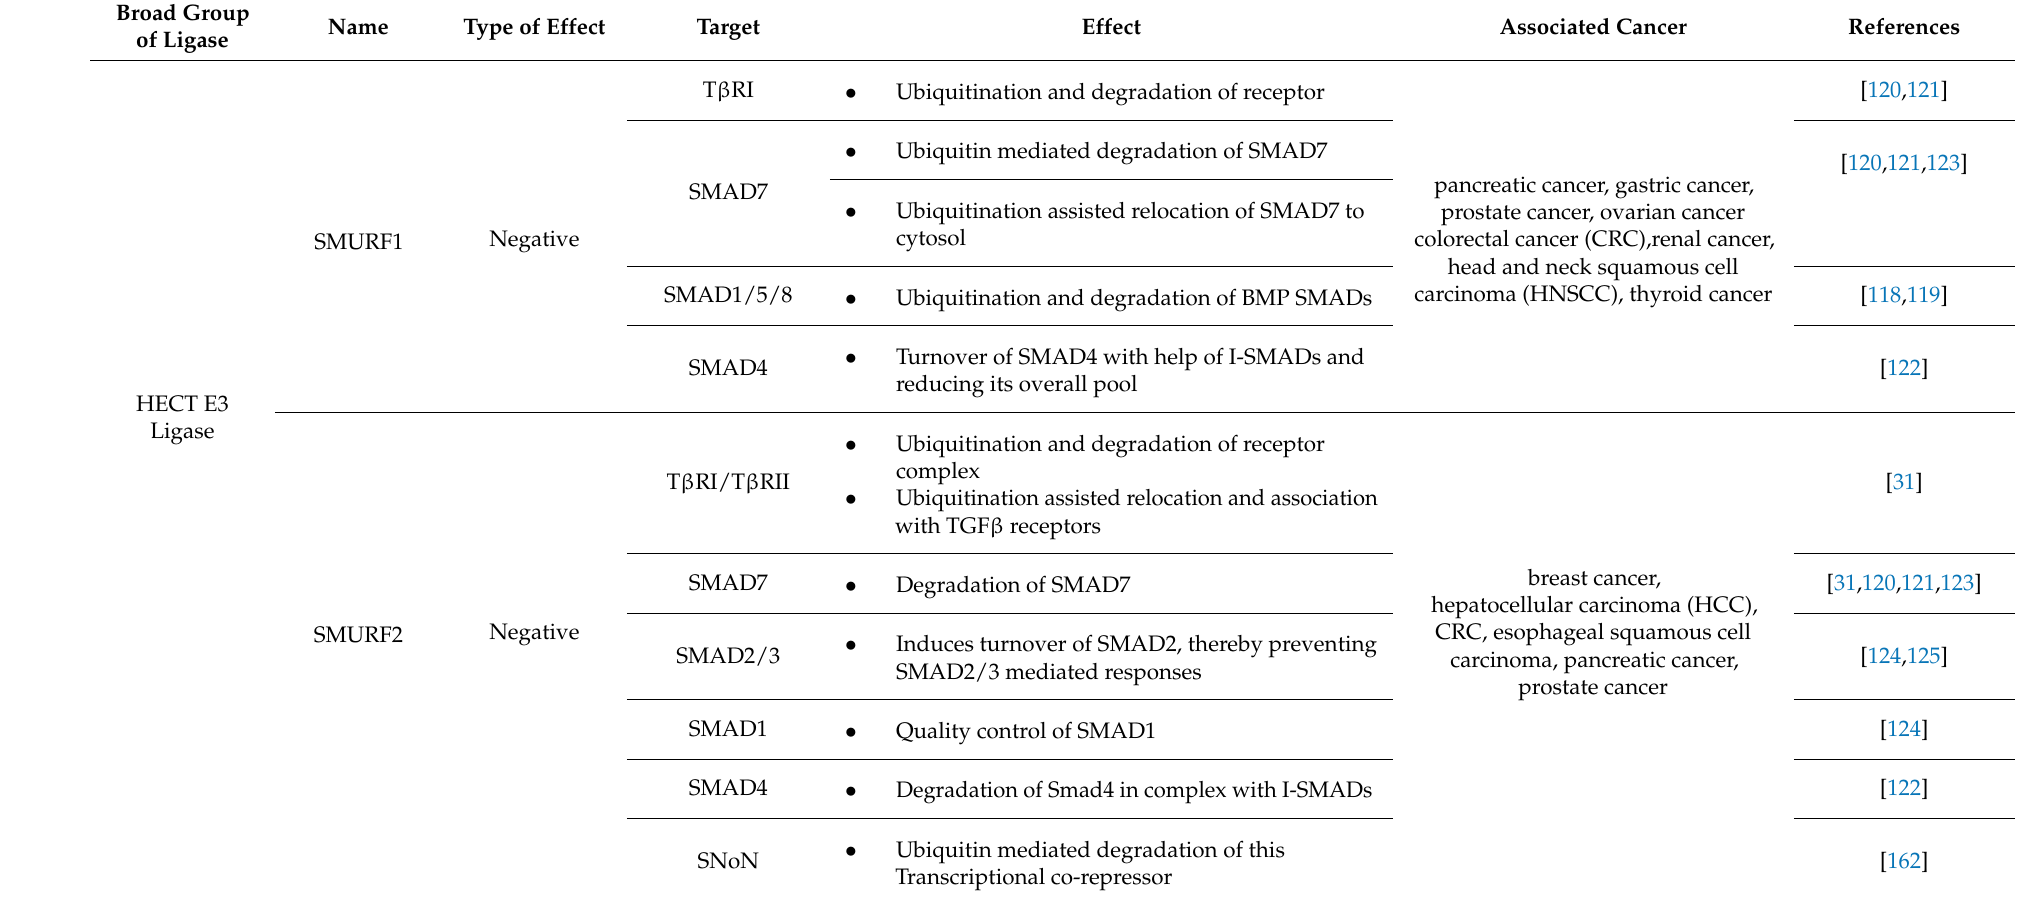
Table 1. List of E3 ubiquitin ligases and their involvement in TGF β signaling in various